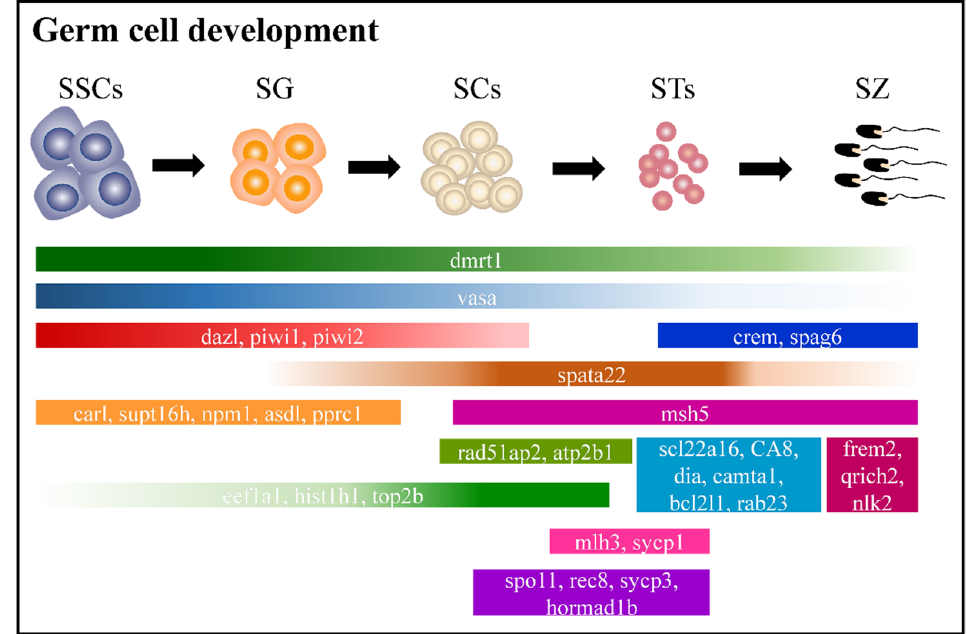
Figure 8. Male, orange-spotted grouper spermatogenesis model. Black arrows indicate the direction of differentiation. The expression pattern of key marker genes (both previously known and discovered in this study) are indicated by boxes. SSCs, spermatogonia stem cells; SG, spermatogonium; SC, spermatocyte; ST, spermatid; SZ, spermatozoon.